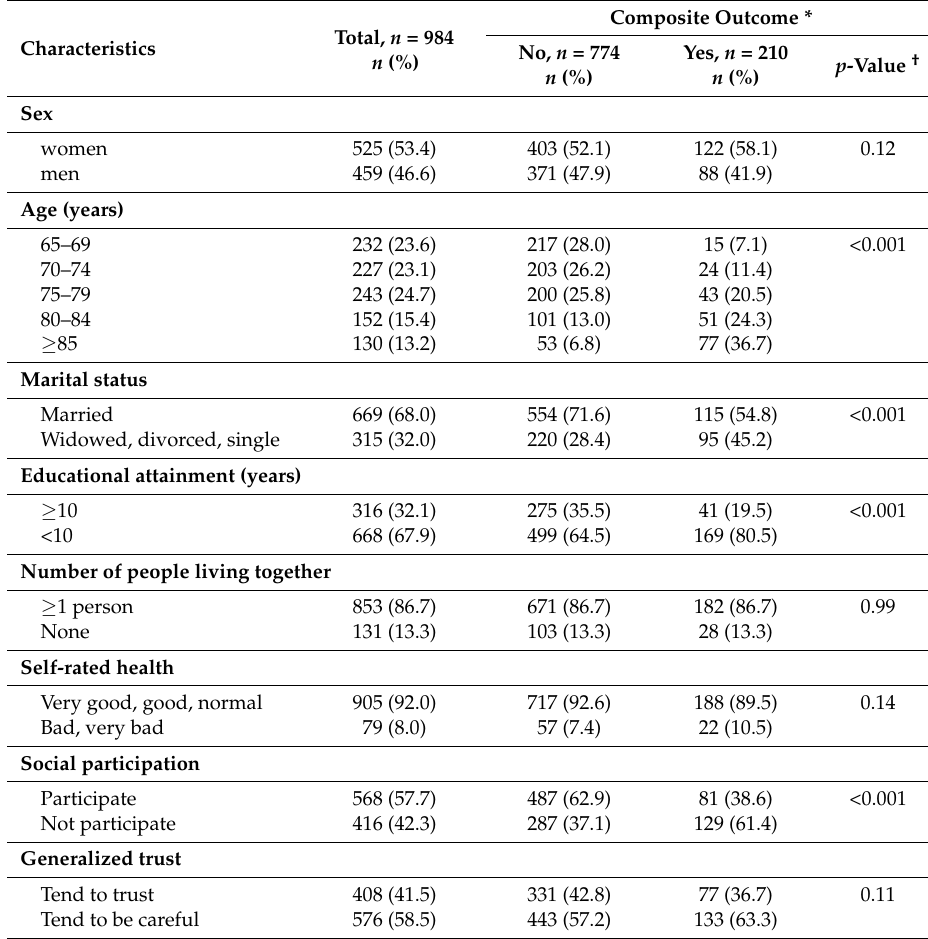
Table 1. Baseline characteristics of the study